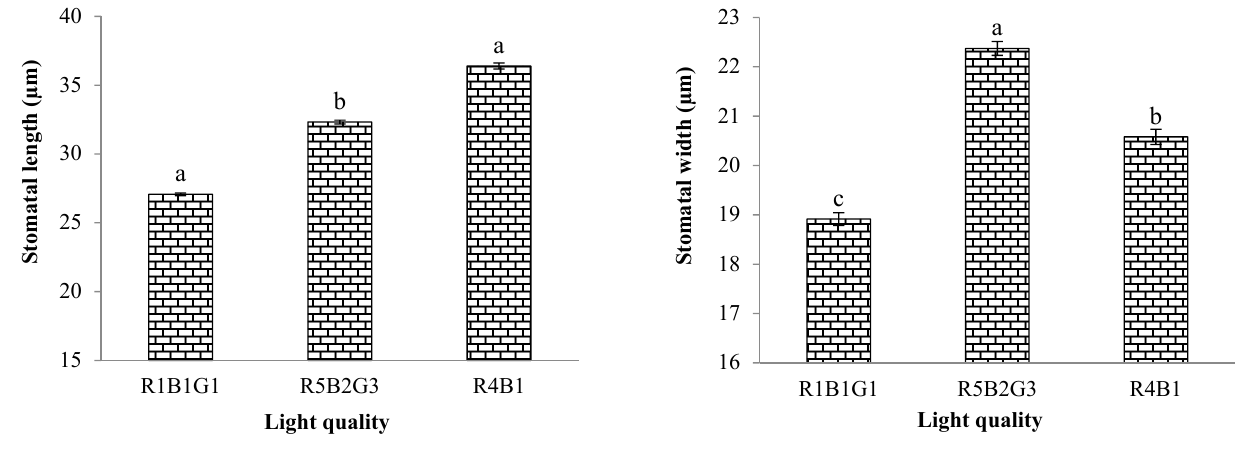
Figure 5. The abaxial epidermis of spinach leaves at different light qualities: ( a ) R4B1, ( b ) R5B2G3 and ( c ) R1B1G1. Scale bar is 50 µm.